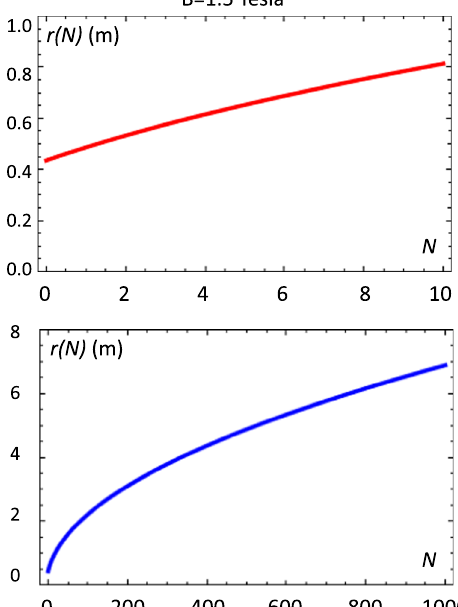
FIG. 2. The bending radius vs turn, from 1st turn to 10th turn (top) and from 1st turn to 1000th turn